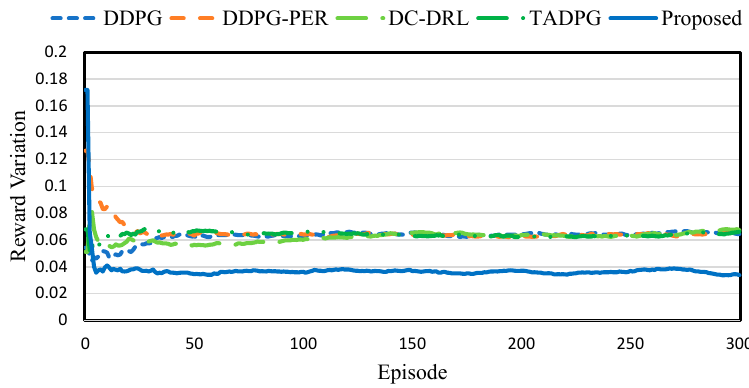
Figure 7. Normalized reward comparison with 10 and 20 edge servers.